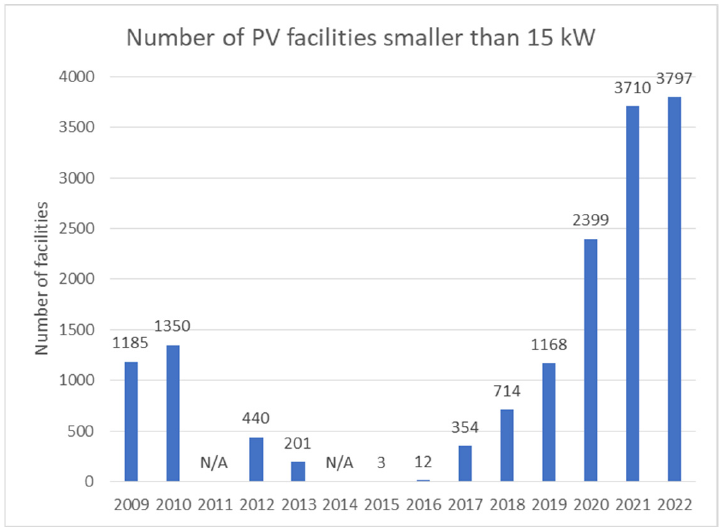
Figure 6. Number of PV facilities (for electricity production) smaller than 15 kW in Israel.